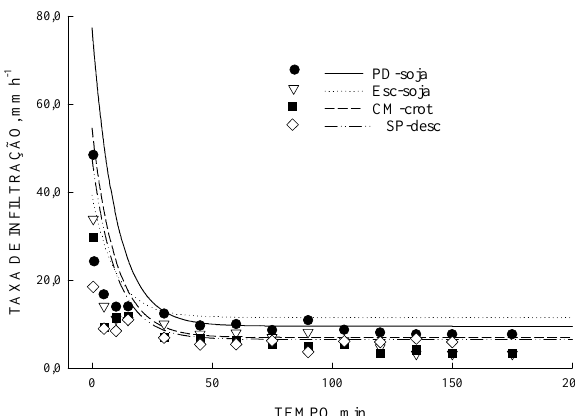
Figura 5. Infiltração de água no solo determinada pelo método dos anéis concêntricos e curva de infiltração calculada pela equação de Horton, em solo sob diferentes sistemas de